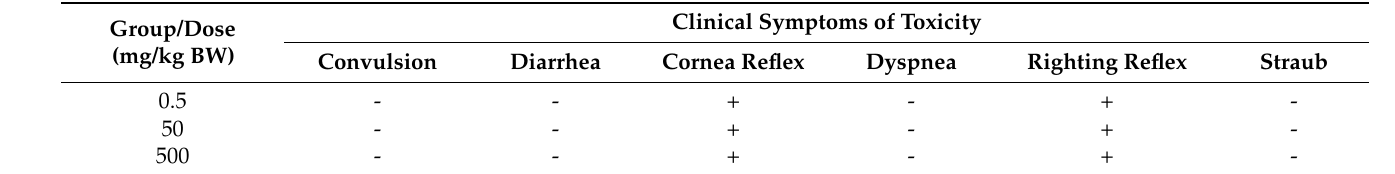
Table 2. The clinical symptoms for 14 days of observation in the acute toxicity study of IgY anti-RBD spike SARS-CoV-2.